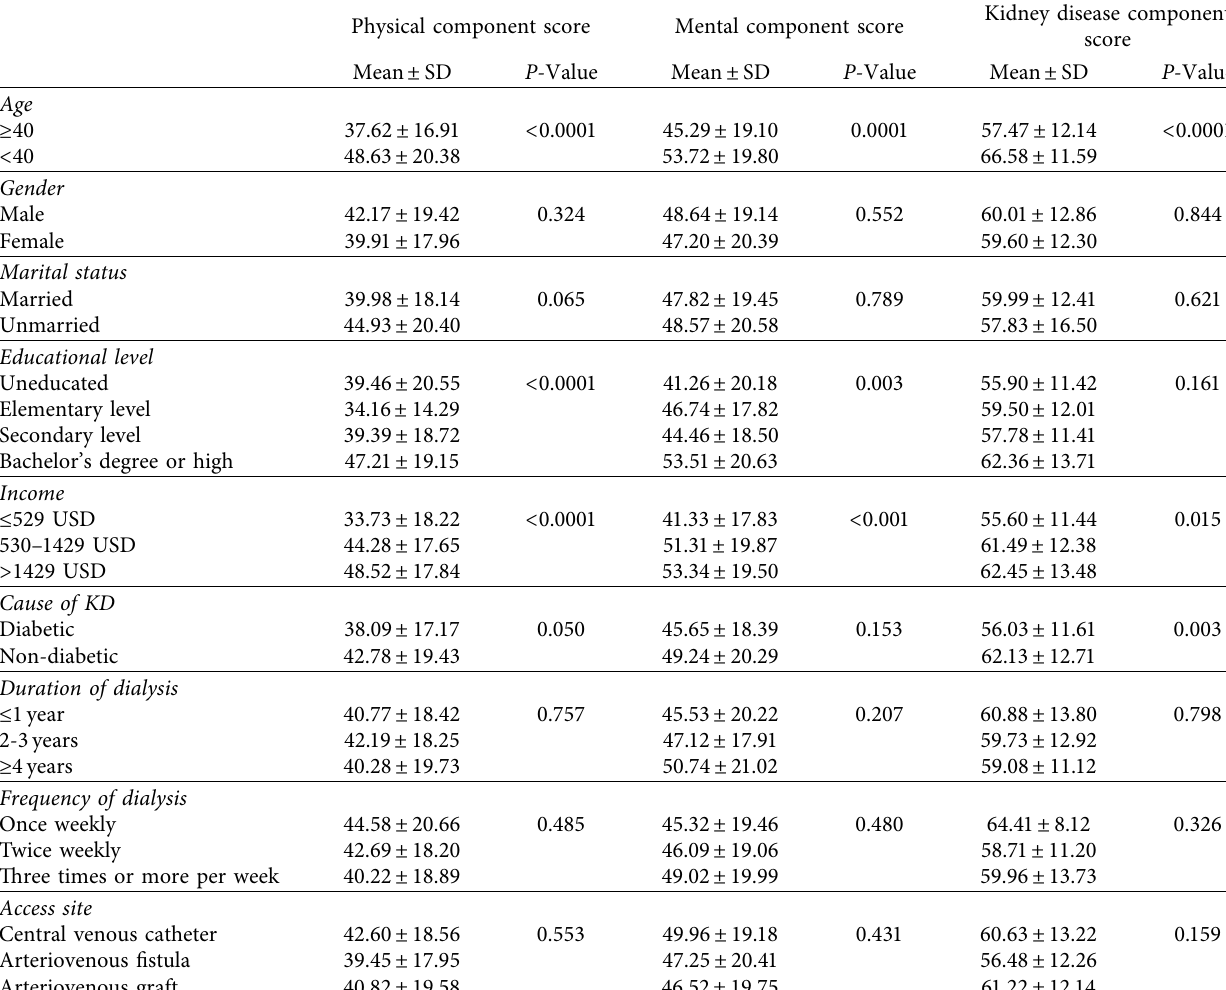
Figure 2: General health evaluation. (a) Tis year (2022). (b) Compared to the previous year (2021). Table 3: Quality of life component scores relationship with demographic and clinical